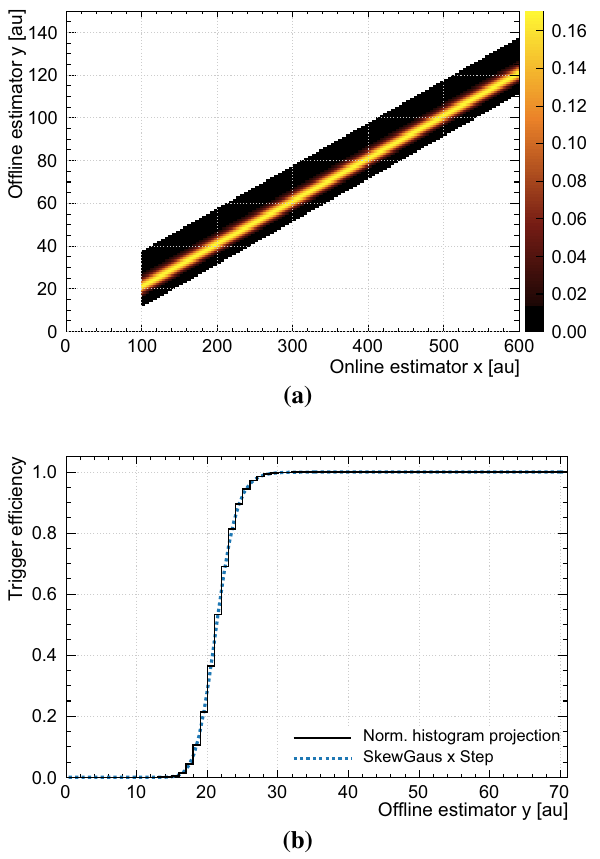
Fig. 7 Skewed Gaussian example with μ = 0 . 2 y , σ = 3, and λ = 0 . 7. a x vs y. b The normalized y profile. Also shown (blue dashed) is a skewed Gaussian convoluted with a step function, and function parameters are taken at the trigger threshold